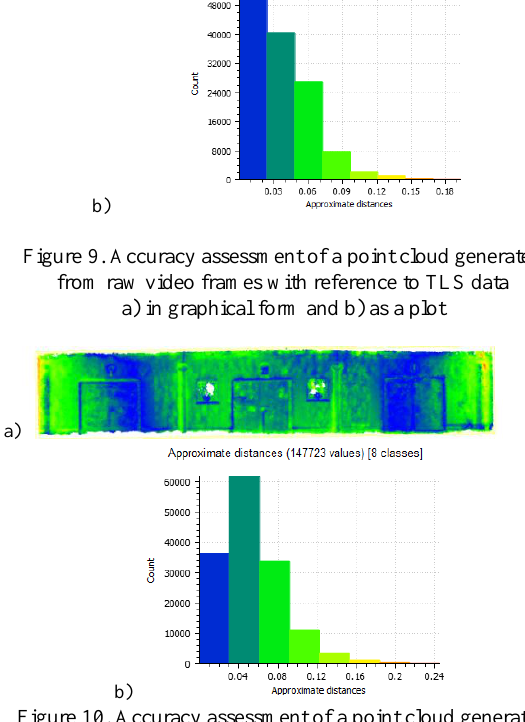
Figure 7. Reference point cloud of test object from Terrestrial Laser Scanner